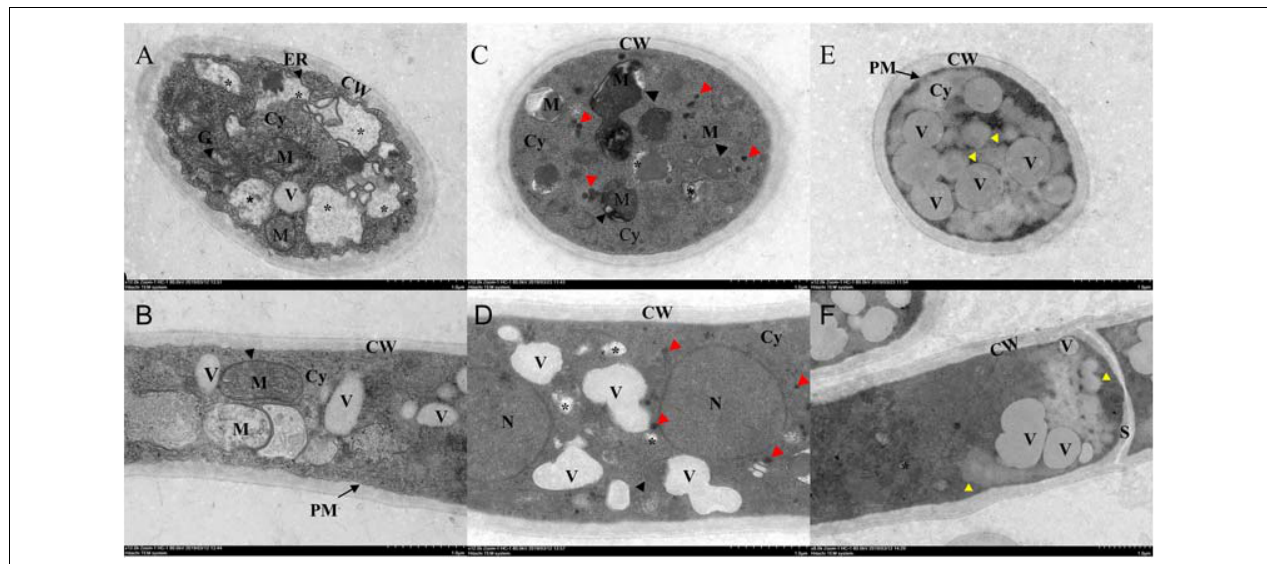
FIGURE 4 | Transmission electron microscopy (TEM) observation of Ps. camelliae-sinensis strain GZHS-2017-010 treated with phenazine-1-carboxylic acid (PCA). (A,B) Control hyphae, with black arrows indicating endoplasmic reticulum, mitochondria, and Golgi apparatus; (C,D) PCA-treated hyphae at the concentration of 6.38 µ g/ml for 120 h, with organelles of mitochondria becoming atrophied (black arrows), the cytoplasm condenses into granulation (red arrows) and small cavities (asterisk) in the cytoplasm; and (E,F) PCA-treated hyphae at the concentration of 11.23 µ g/ml for 120 h, showing serious damage to the organelles (yellow arrows). CW, cell wall; Cy, cytoplasm; ER, endoplasmic reticulum; M, mitochondria; N, nucleus; G, Golgi apparatus; PM, plasma membrane; V, vacuole; and S, septum. Bar = 1 µ